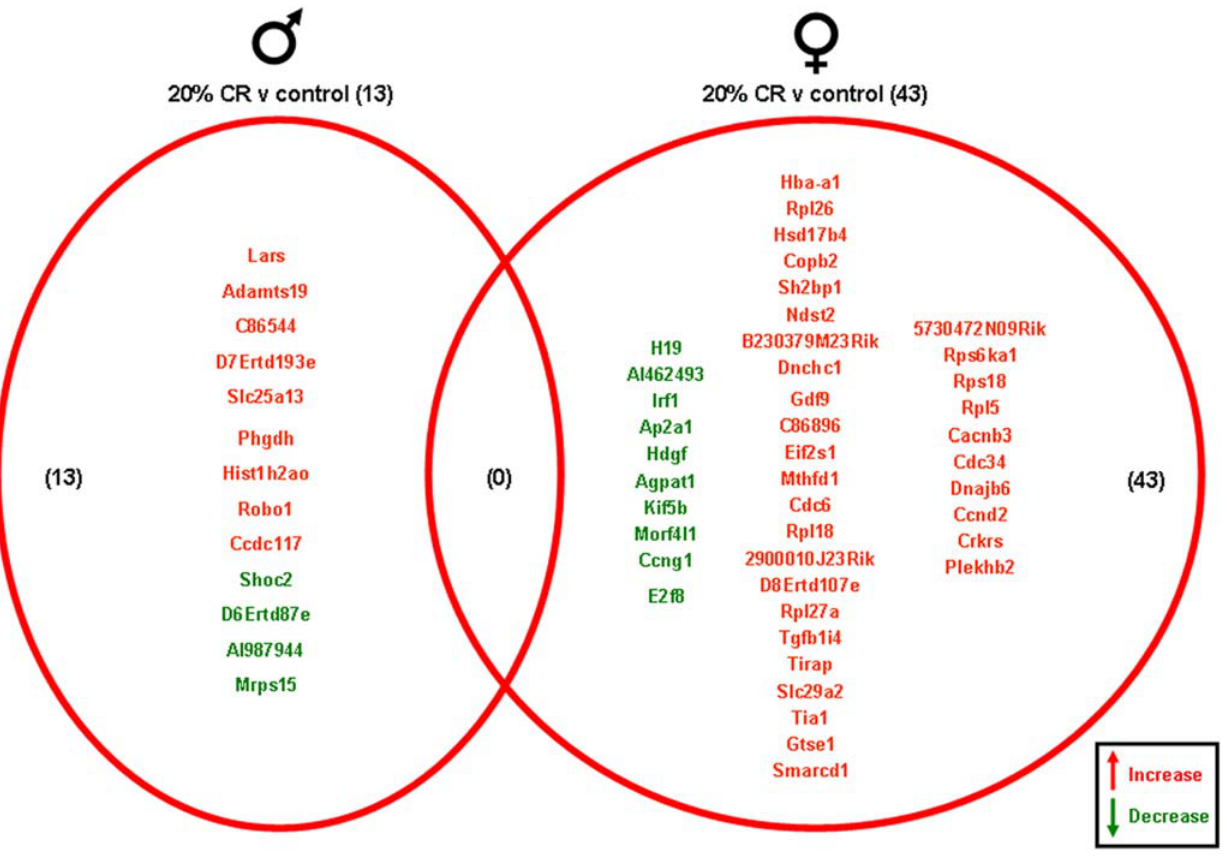
Figure 3. Gene changes in the gonads of male and female rats maintained on the 20% CR diet compared to the gonads of male and female rats maintained on a control ( adlibitum ) diet. Genes that were significantly up-regulated (red) or down-regulated (green) were clustered into a Venn diagram. There were 9 significantly up-regulated and 4 significantly down-regulated genes in the testes collected from 20% CR male rats compared to the genes from testes collected from control ( ad libitum ) male rats. Ovaries collected from 20% CR female rats showed 33 significantly up-regulated (red) and 10 significantly down-regulated (green) genes compared to control ( ad libitum ) female rats. There were no common gene alterations between the 20% CR male and female gonadal tissues. Names of the significantly altered genes can be found in Table S1.